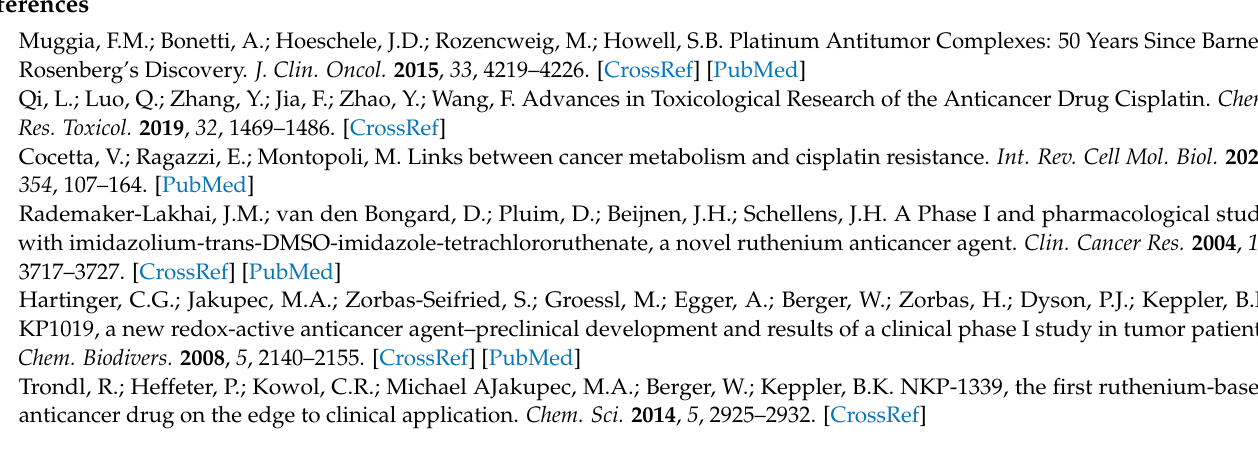
Figure A4. Clinical chemistry and haematology parameters provided by the supplier (Envigo RMS) with reference to female athymic nude Foxn1nu mice.